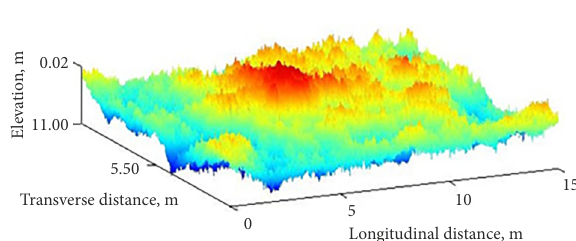
Figure 3. Bridge surface based on the class B road profile